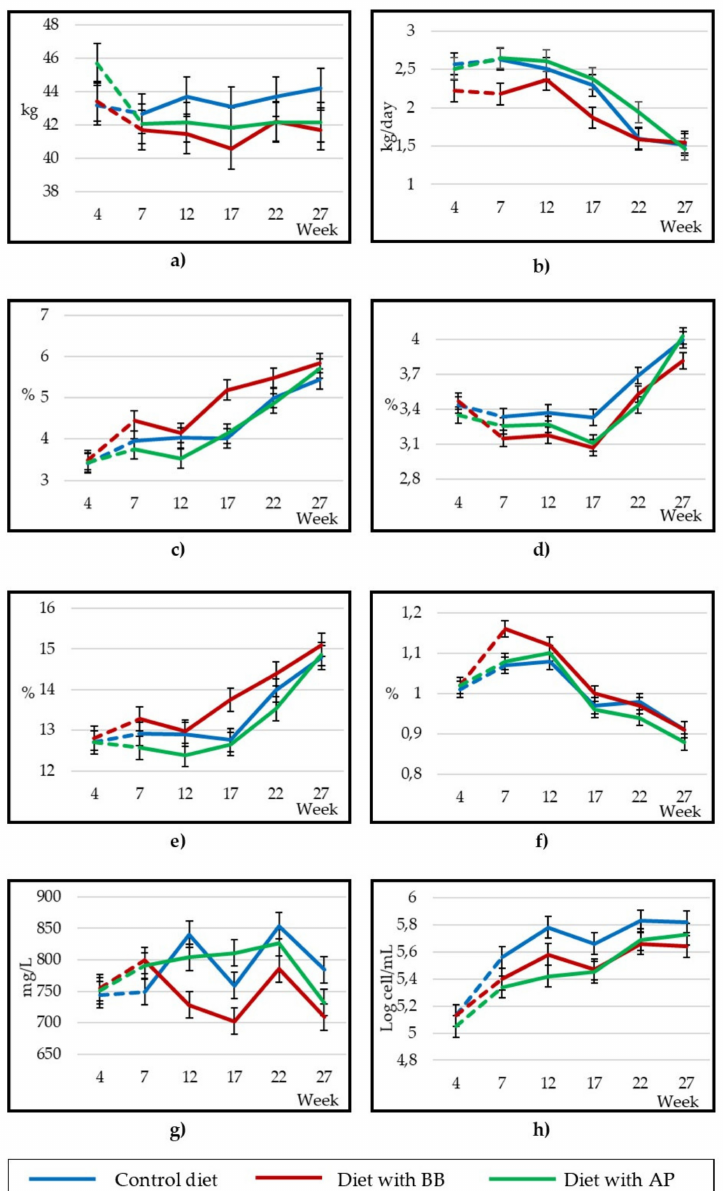
Figure 2. Comparison of changes in body weight ( a ), milk yield ( b ), milk fat ( c ), milk protein ( d ), total solids ( e ), ash ( f ), milk urea ( g ) and somatic cell count ( h ) in goat milk (24 goats per group) from 7th to 27th lactation